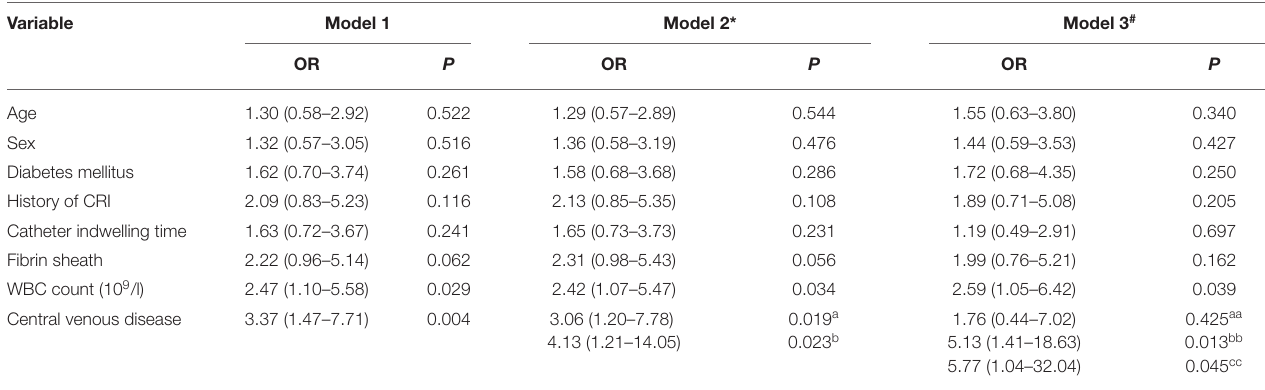
TABLE 3 | Multivariate logistic regression analysis of microbial colonization of